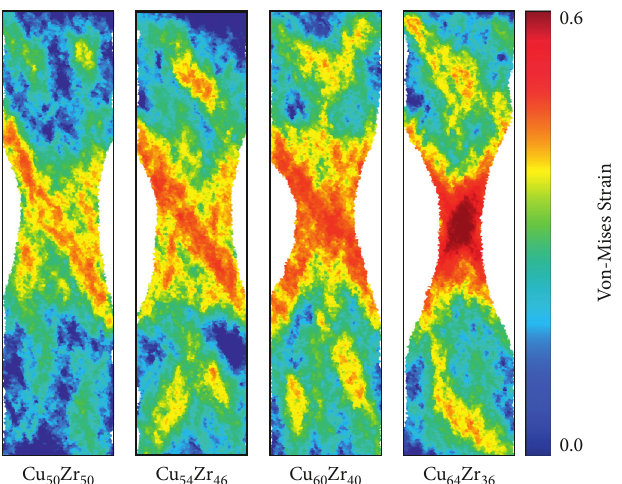
Figure 6: The atomic configurations of the monolithic MGs at the end stage of tensile loading. The strain value for Cu Cu 60 Zr 40 , and Cu 64 Zr 36 is 26.2%, 25.8%, 24.7%, and 24.8%, respectively.